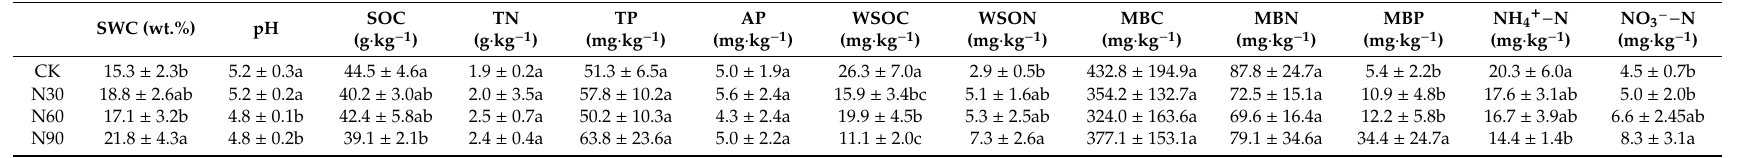
Table 1. Soil biochemical properties of sample plots in the moso bamboo forest under di ff erent SND levels. Values represent the mean ± SD ( n = 9). SWC